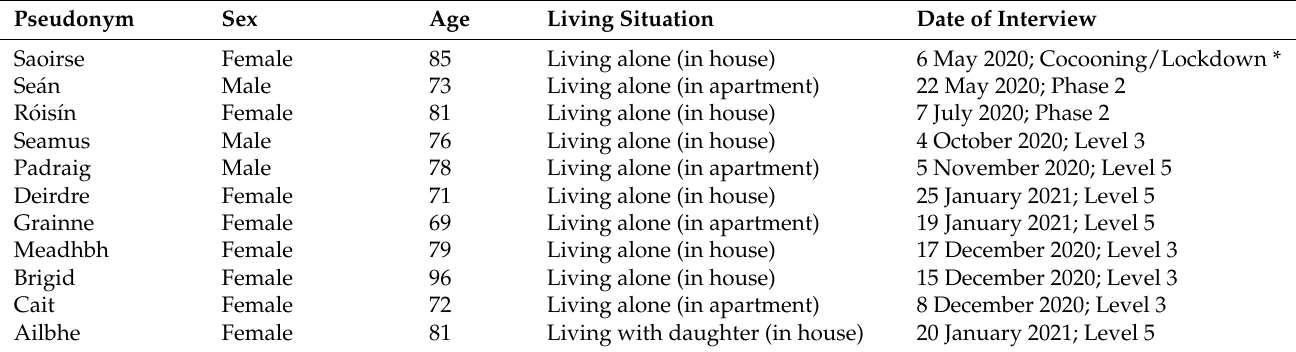
Table 1. Sample characteristics of the 11 study participants involved in grounded theory